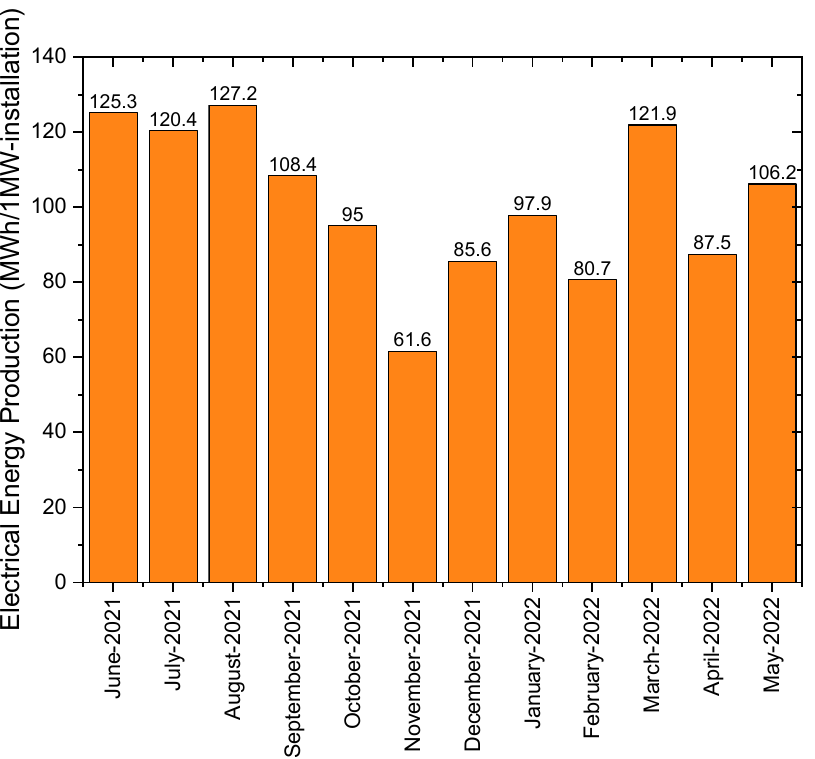
Figure 13. Monthly electrical production in the south of Thailand from a 1 MW PV installation site from June 2021 to May 2022.